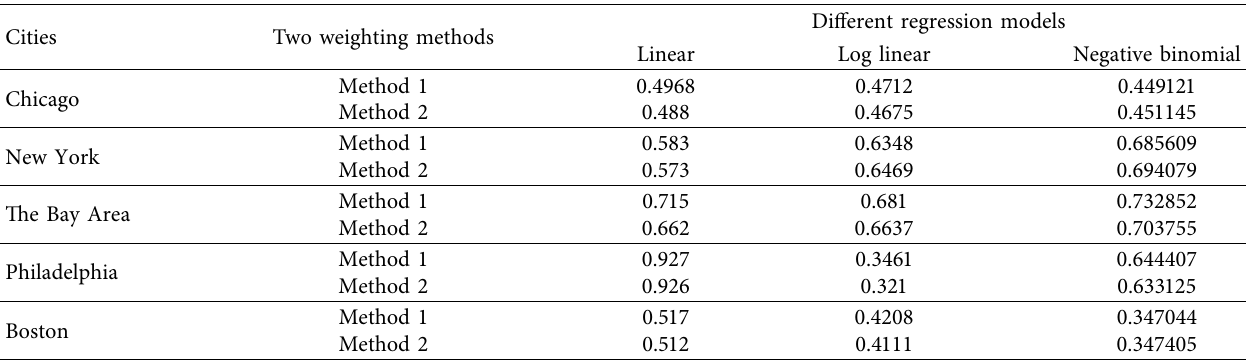
Table 14: Table of the adjusted R 2 of negative binomial regression model of two weighting methods in five cities.